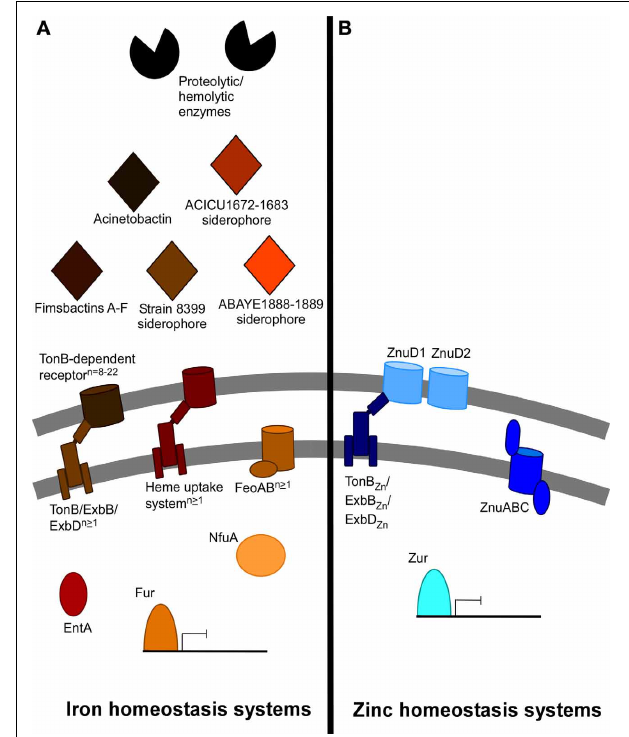
FIGURE 1 | Summary of predicted and described iron and non-iron metal acquisition systems in A. baumannii . The iron and non-iron systems encoded within the A. baumannii genome vary dramatically between different strains. (A) This panel depicts the iron acquisition and utilization systems identified or described among the different A. baumannii strains. Secretion of enzymes such as phospholipase C and others may contribute to hemolysis and hemoglobin release from red blood cells. At least five clusters of genes for siderophore synthesis and secretion are dispersed among different strains. These include acinetobactin, fimsbactins A-F, the strain 8399 ( om73-entD ) siderophore, as well as siderophores produced by the ACICU1672-1683 and the ABAYE1888-1899 clusters. EntA is required for iron acquisition due to its involvement in the biosynthesis of the acinetobactin precursor 2,3-dihydroxybenzoic acid. Siderophores are recognized by TonB-dependent receptors, of which 8–22 have been discovered among the sequenced strains. At least one of multiple encoded TonB/ExbB/ExbD systems generates and provides energy to the TonB-dependent receptors, and at least one FeoAB ferrous iron transport system has been identified in all sequenced strains. Finally, 1–2 heme uptake systems have been identified among A. baumannii strains. NfuA is a Fe-S cluster protein required for iron utilization in the cytoplasm. Regulation of these numerous systems likely depends on the conserved Fur repressor. (B) This panel depicts the zinc acquisition and metabolism systems described in A. baumannii ATCC 17978. Outer membrane transport of zinc may occur via two zinc-regulated TonB-dependent receptors, energized by a zinc-regulated TonB/ExbB/ExbD system. Inner membrane transport is mediated by the ZnuABC transporter. Zur is a conserved repressor that controls the expression of znuABC and likely the other identified zinc